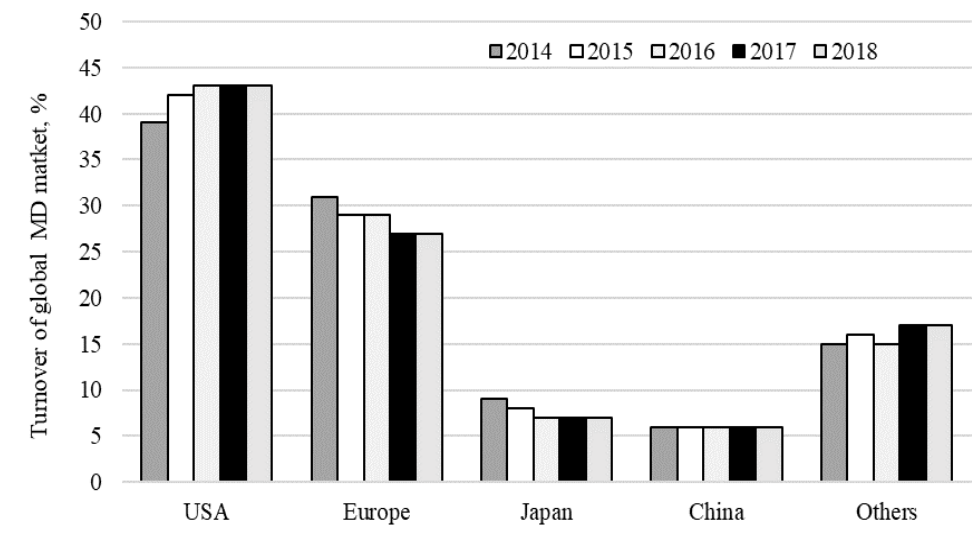
Fig. 1. The main players on the world MD market (developed by the author based on MedTech Europe